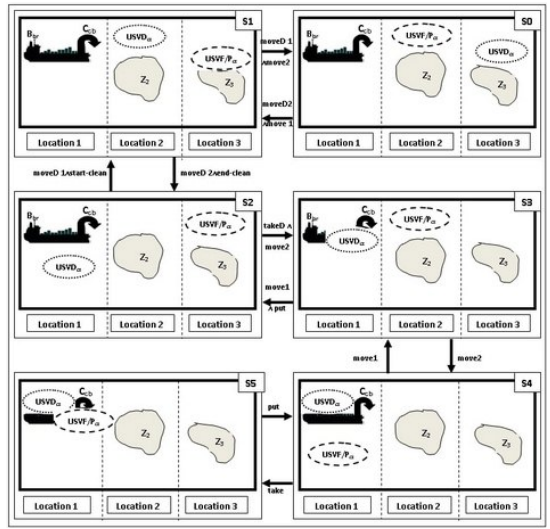
Figure 12: A state transition system for the UAVS-C